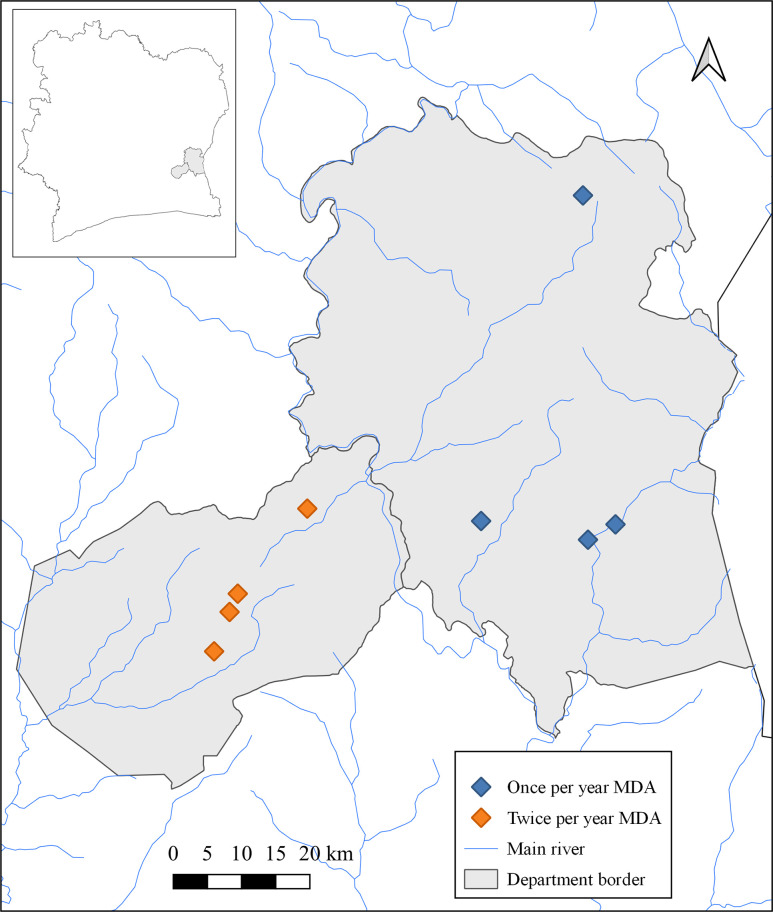
Map of study sites in the health Districts of Abengourou and Akoupé in eastern Côte d’Ivoire.Geographic coordinates of each study site were recorded using a hand-held global positioning system (GPS) receiver of the cell phone and Arc Map 10.2.1 (Environmental Systems Research Institute Inc.; Redlands, USA) was used to generate the map of the study sites.